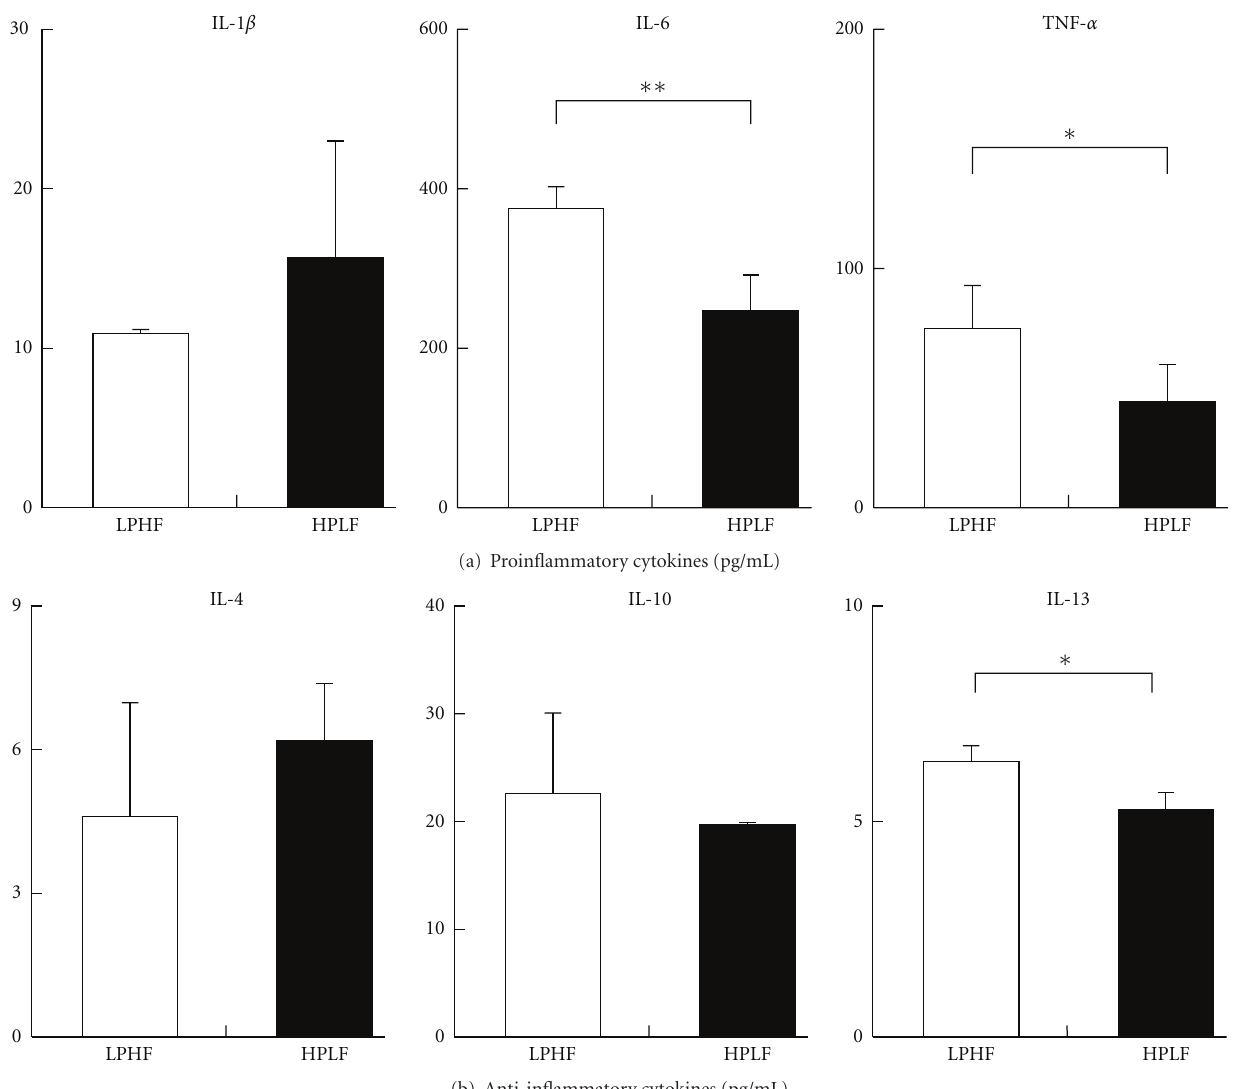
Figure 3: Inflammatory cytokines levels in splenocyte supernatant. LPHF: weekly intraperitoneal injection of adriamycin (2mg/kgBW) for six weeks thereafter a 7% protein and 40% fat diet for five weeks. HPLF: weekly intraperitoneal injection of adriamycin (2mg/kgBW) for six weeks thereafter a 30% protein and 7% fat diet for five weeks. ∗ Statistical di ff erence between the LPHF and HPLF groups by Student’s t -test at P < . 05, ∗∗ P < .